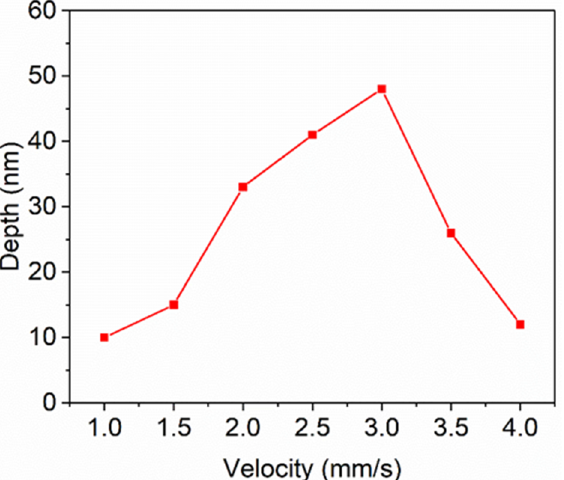
Figure 8. LSFL depth versus scanning velocity at a constant laser fluence of 0.66 J/cm 2 .